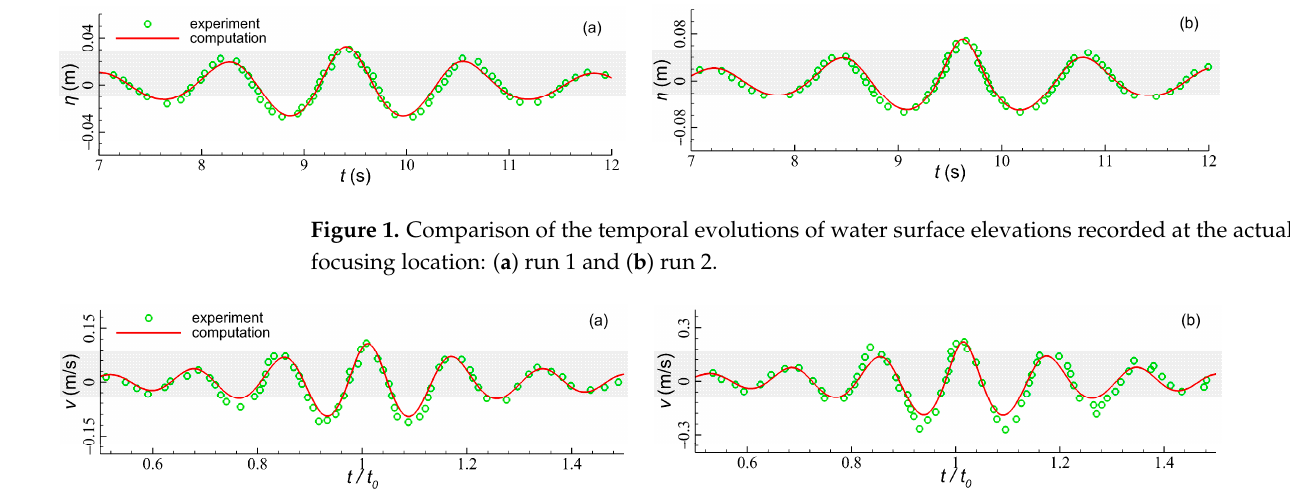
Figure 2. Temporal evolutions of the horizontal velocities: ( a ) run 1 and ( b ) run 2.